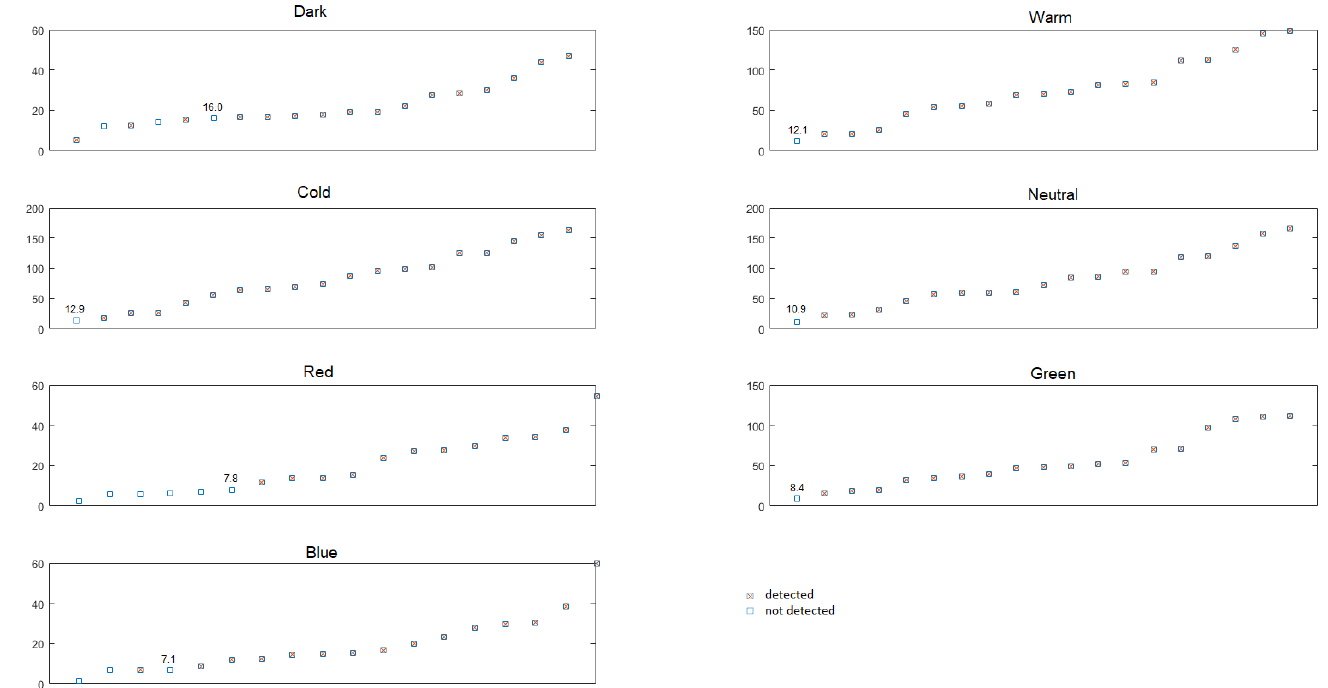
Figure 15. Analysis of the F-points’ detection ability, depending on the MeanG feature, divided bystudy type.